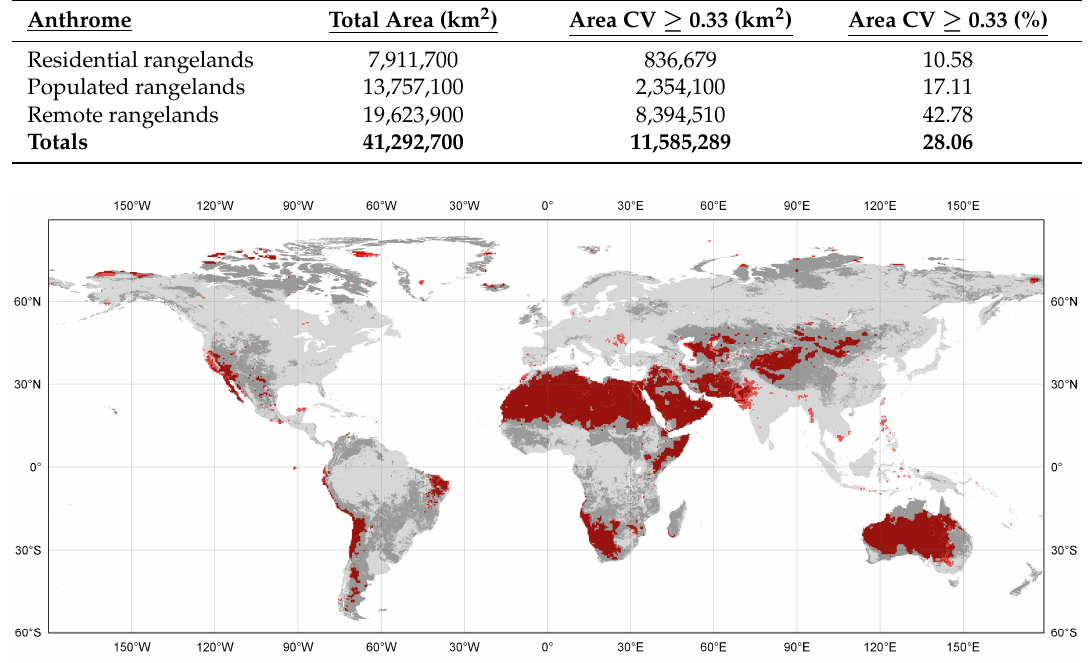
Table 1. Proportions of rangeland anthromes (Ellis and Ramankutty 2008 [2]) where the coefficient of